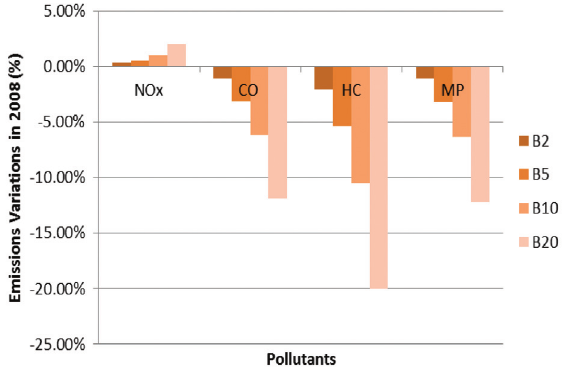
Fig. 4 - Variation of atmospheric emissions at different biodiesel blends added to diesel oil in 2008 in the